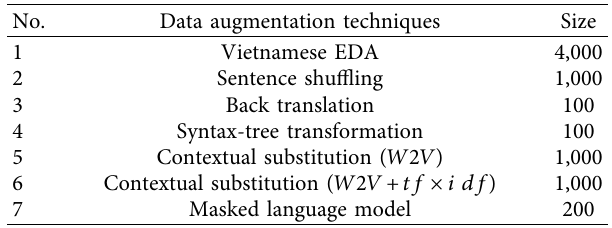
Table 4: The size of new samples for each polarity when applying the data augmentation